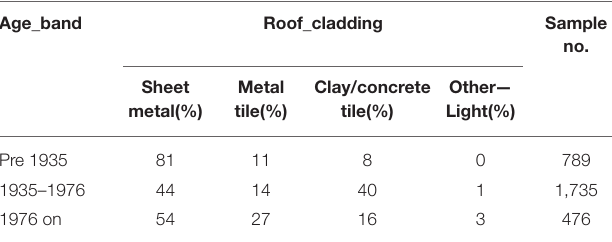
TABLE 9 | Comparison of wall cladding between EQC portfolio and survey data. Wall Cladding no.